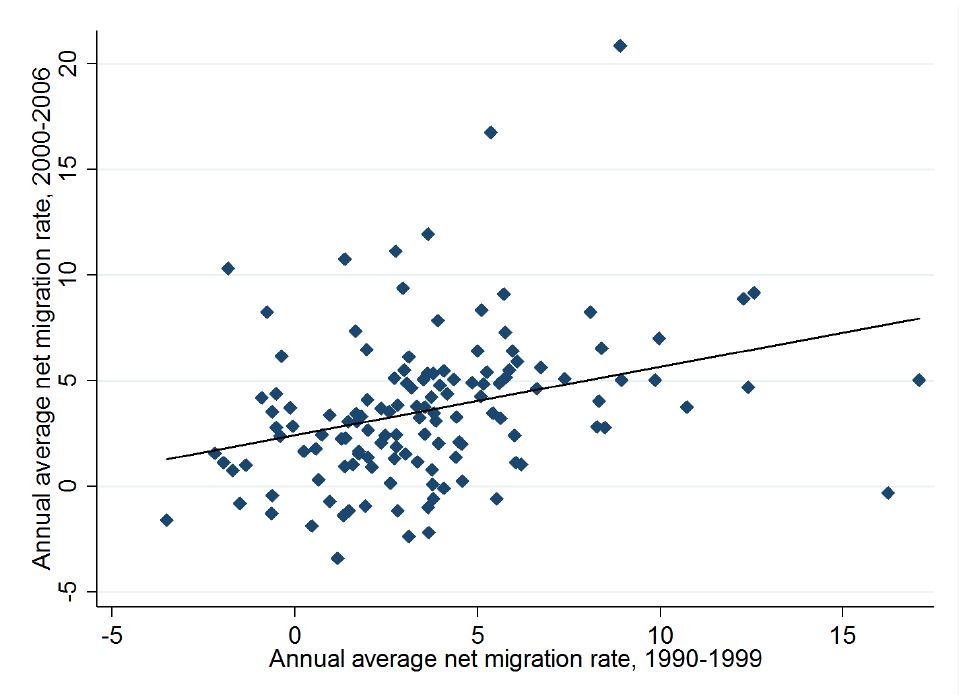
Figure 3: EU-15: net migration rate 2000-2006 and net migration